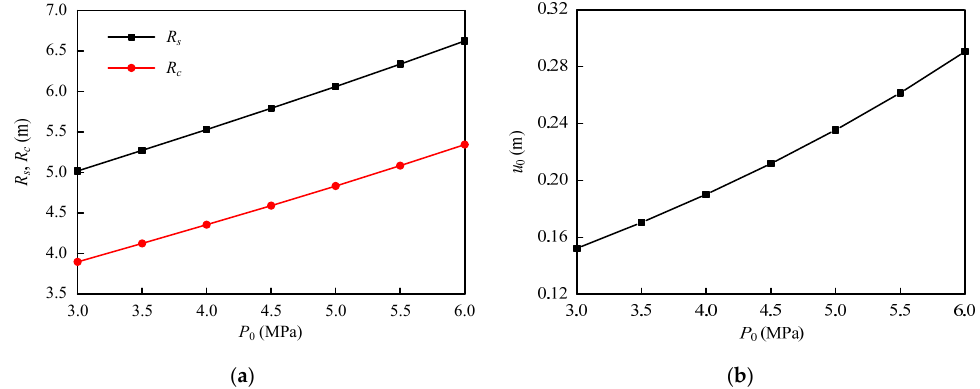
Figure 7. Effect of seepage force on the radii of strain-softening and crushed regions and surface displacement. ( a ) R s and R c ; ( b ) u 0 . The radial and tangential stresses in the tunnel surrounding rock with different seep- age forces are shown in Figure 8. It can be seen that the radial stress is always less than the tangential stress. The radial stress at the tunnel wall is consistent with the initial sup- port resistance, and it presents an increasing trend with the increase in radius. The tan- gential stress first increases in the broken and strain-softening regions and then decreases in the elastic region, and the peak value of tangential stress appears at the interface be- tween elastic and strain-softening regions. The peak value of tangential stress increases with the increase in seepage force. For example, as the P 0 value increases from 3.0 MPa to 6.0 MPa, the peak value of tangential stress increase by 6.88 MPa, with an increment of 16.95%. ( a ) ( b ) Figure 8. Effect of seepage force on the stress distribution in the tunnel surrounding rock. ( a ) σ r ; ( b ) σ θ . 5.2. Softening Modulus Coefficient of Cohesion The effect of softening modulus coefficient of cohesion on the radii of strain-softening and crushed regions and surface displacement around the tunnel is shown in Figure 9. It can be seen that the radii of strain-softening and crushed regions both increase with the